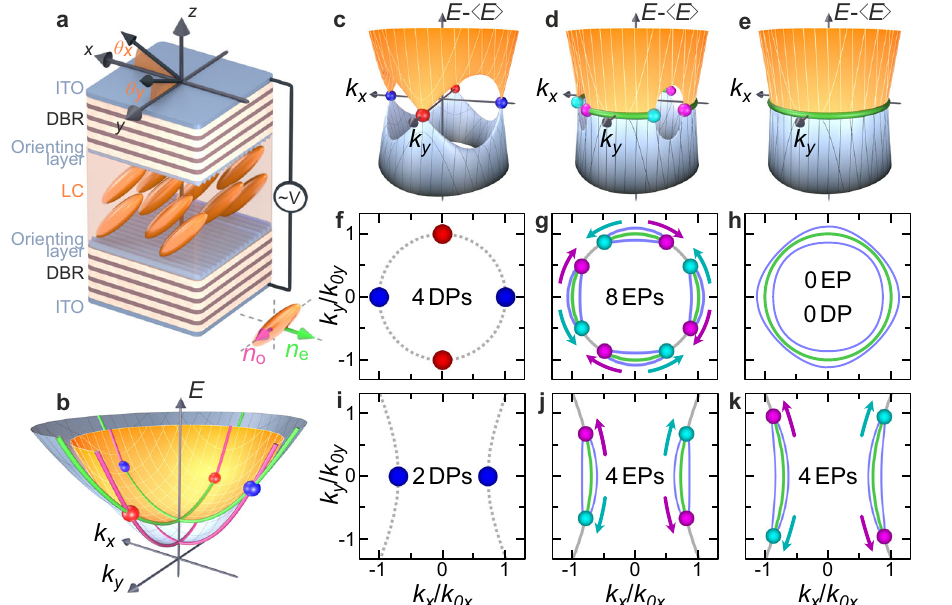
Fig.2|Schemeoftheexperimentandthepossiblebehaviorsoftheexceptional points. a Distributed Bragg Re fl ector (DBR) based microcavity fi lled by liquid